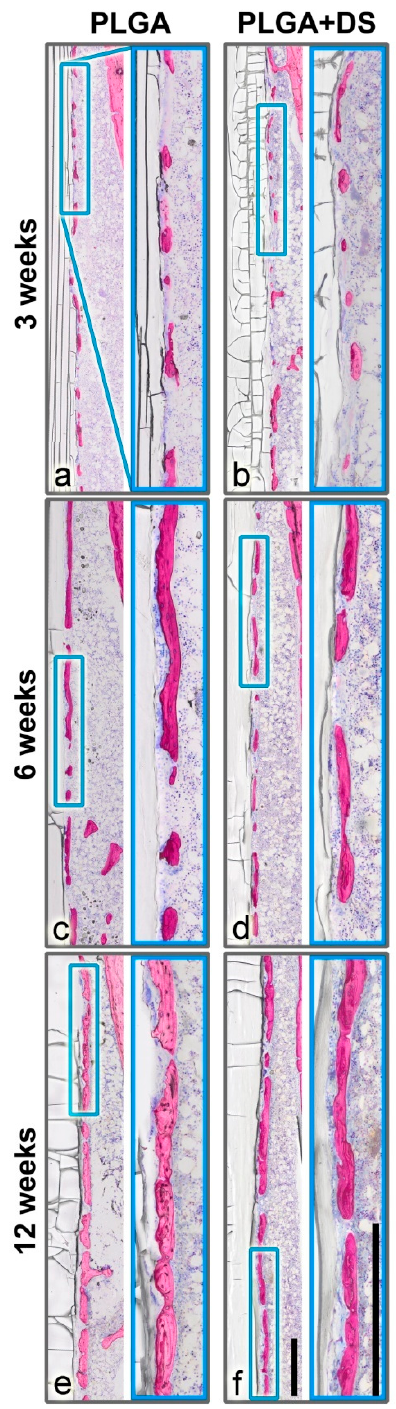
Figure 3. Peri-implant bone capsule. A layer of new bone was formed in close vicinity to the PLGA rods, in all samples. ( a , b ) After 3 weeks, only small islands were lining the implant surface. ( c , d ) After 6 weeks, the bone islands tended to increase in length and thickness. ( e , f ) After 12 weeks, the bone capsule covered the most part of the implant forming a fenestrated capsule in the medullary space. The piBC, i.e., the percentage of the rod surface that is surrounded by newly formed bone, tended to be higher in PLGA groups than in PLGA+DS8 groups. However, new bone volume fraction (nBV/TV) did not differ between the PLGA and PLGA+DS8 groups. Scale bar in overview and magnification images, 500 µm.